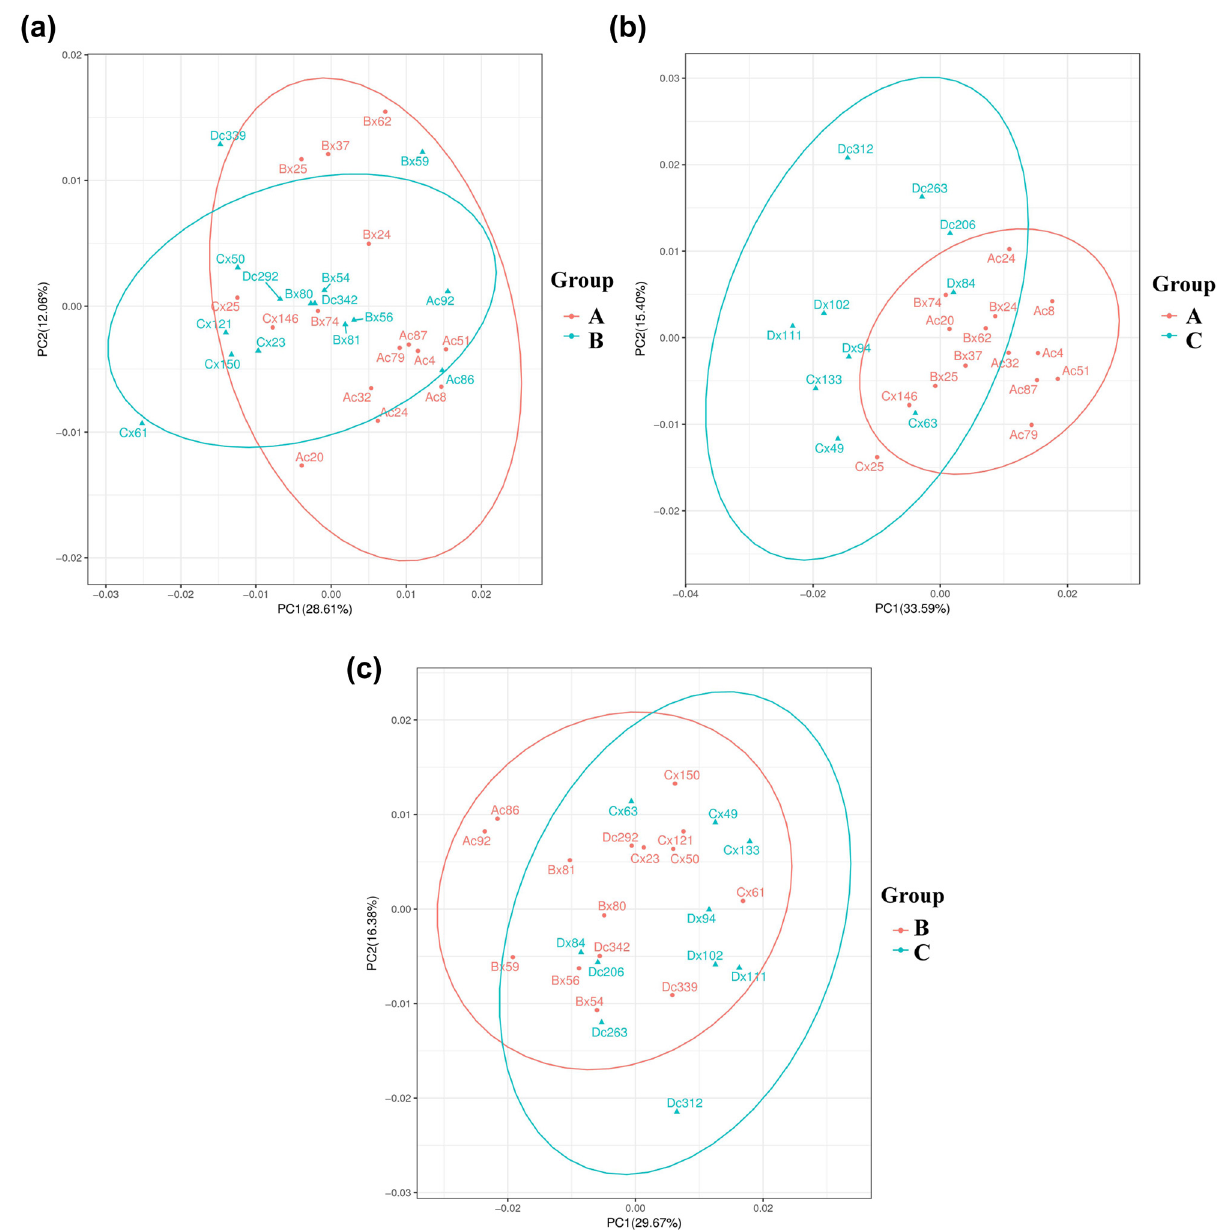
Figure 1: PCA score plots of serum samples from the A, B and C groups. ( a ) PCA score plots in the B vs A group. ( b ) PCA score plots in the C vs A group. ( c ) PCA score plots in the C vs B group. A: people with 25 - hydroxyvitamin D ( 25 ( OH ) D ) ≥ 40 ng/mL; B: people with 30 ng/mL ≤ 25 ( OH ) D < 40 ng/mL; C: people with 25 ( OH ) D < 30